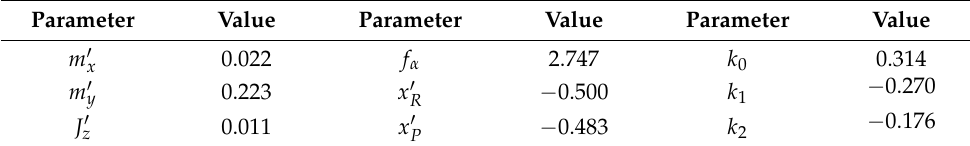
Table 6. Related parameters in the MMG model.